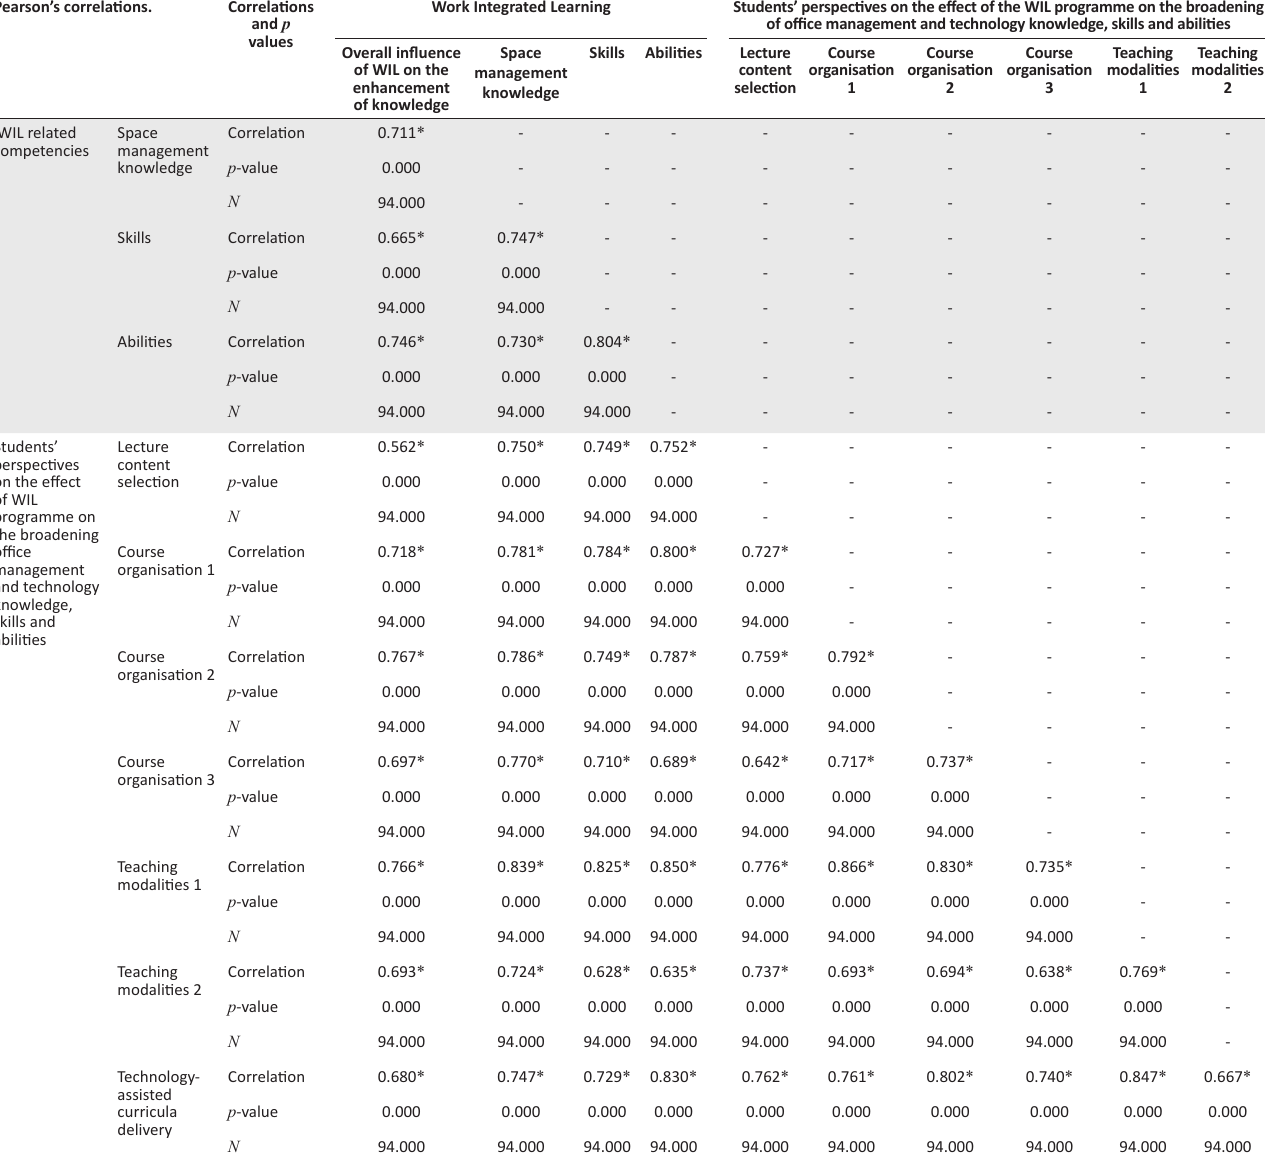
TABLE 14: Correlations between Work Integrated Learning and students’ perspectives. Pearson’s